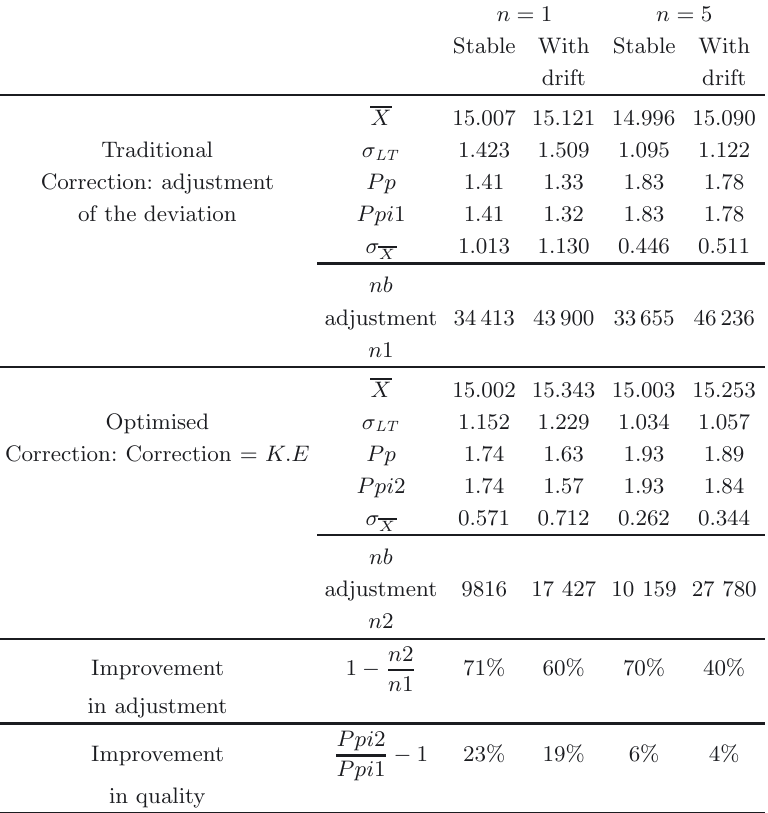
Table 7. Results of the